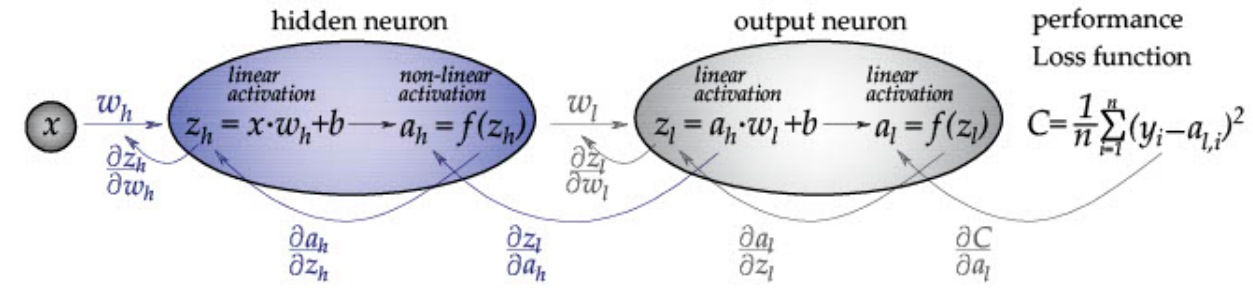
Figure 2. Representation of a two-layer feed-forward neural network and backpropagation.